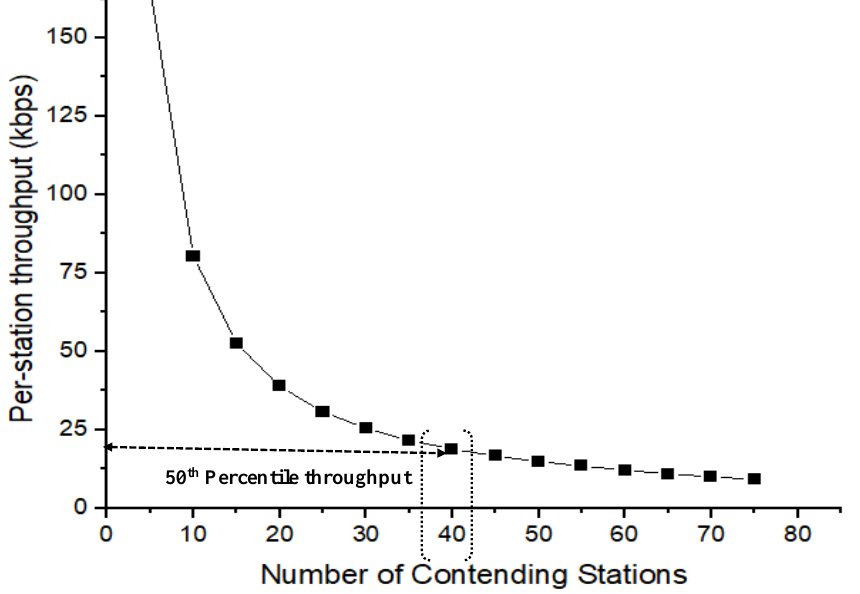
Figure 14. Per-station 50th percentile throughput for